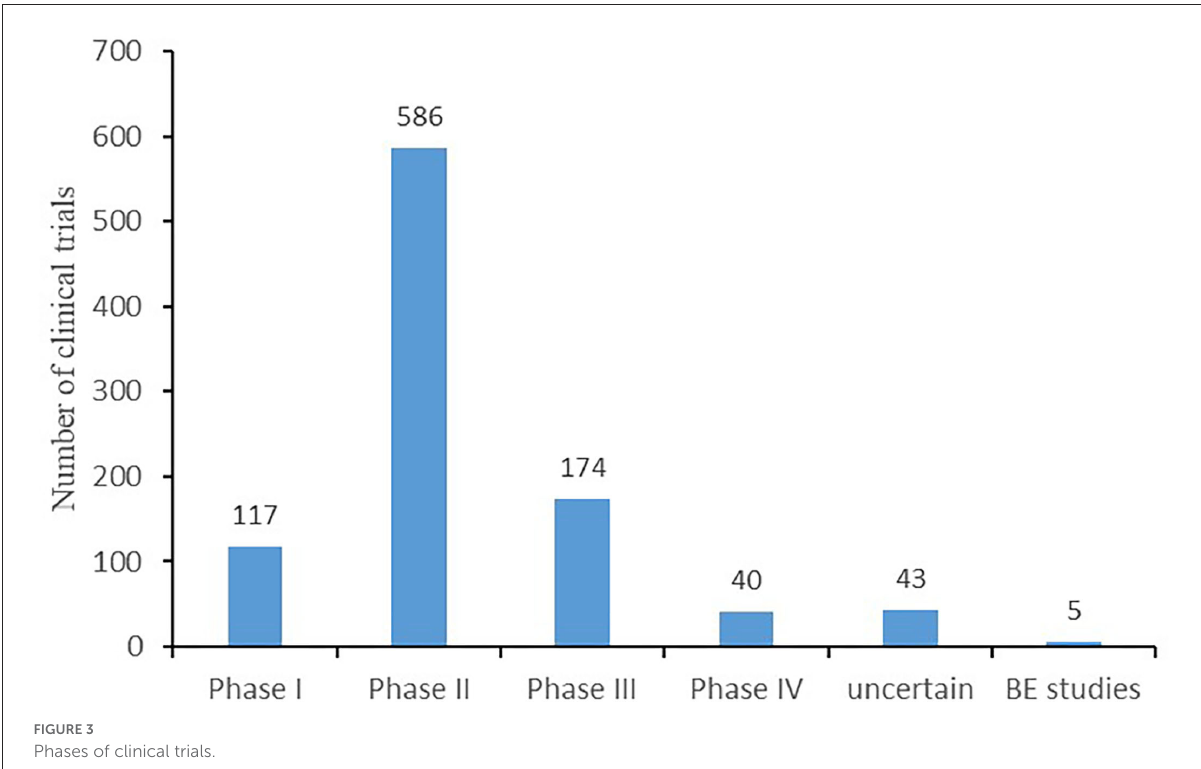
FIGURE3 Phases of clinical